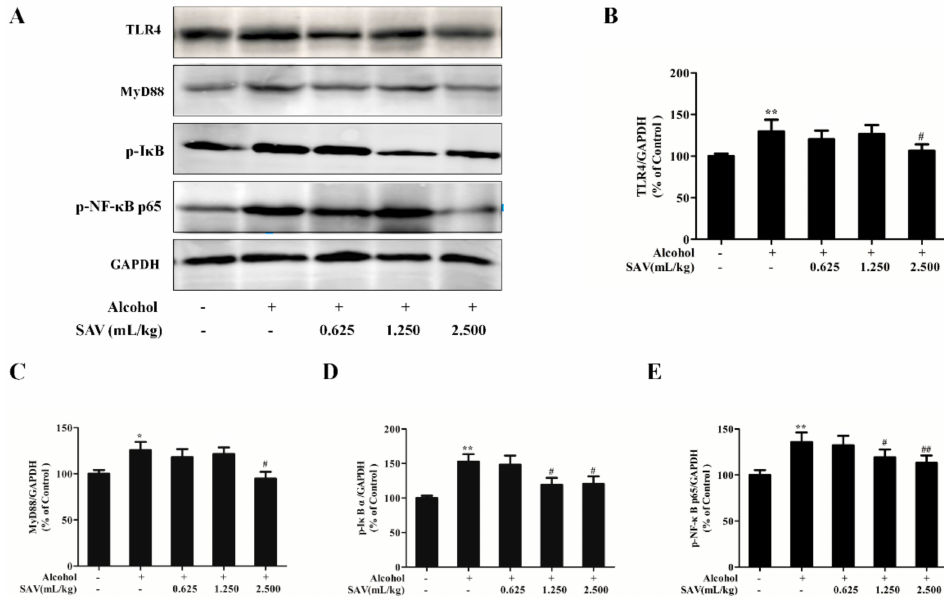
Figure 5. Effect of SAV on TLR4-induced inflammatory response. ( A ) The expression levels of TLR4, MyD88, p-I κ B α and p-NF- κ B p65 were analyzed by western blot; ( B ) Quantification of TLR4 expression; ( C ) Quantification of MyD88 expression; ( D ) Quantification of p-I κ B α expression; ( E ) Quantification of p-NF- κ B p65 expression. All data are expressed as mean ± SEM ( n = 5–7). * p < 0.05 versus control group, ** p < 0.01 versus control group, # p < 0.05, ## p < 0.01 versus ethanol